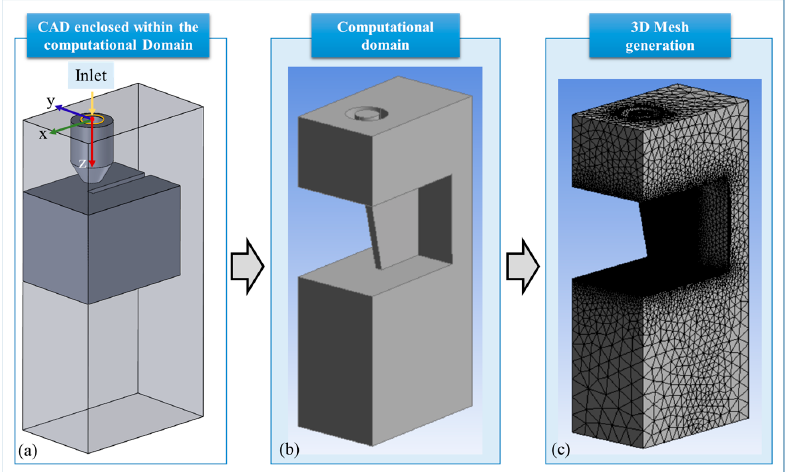
Figure 4. CFD model. ( a ) CAD model enclosed within the computational domain, ( b ) computational domain, and ( c ) mesh generation.